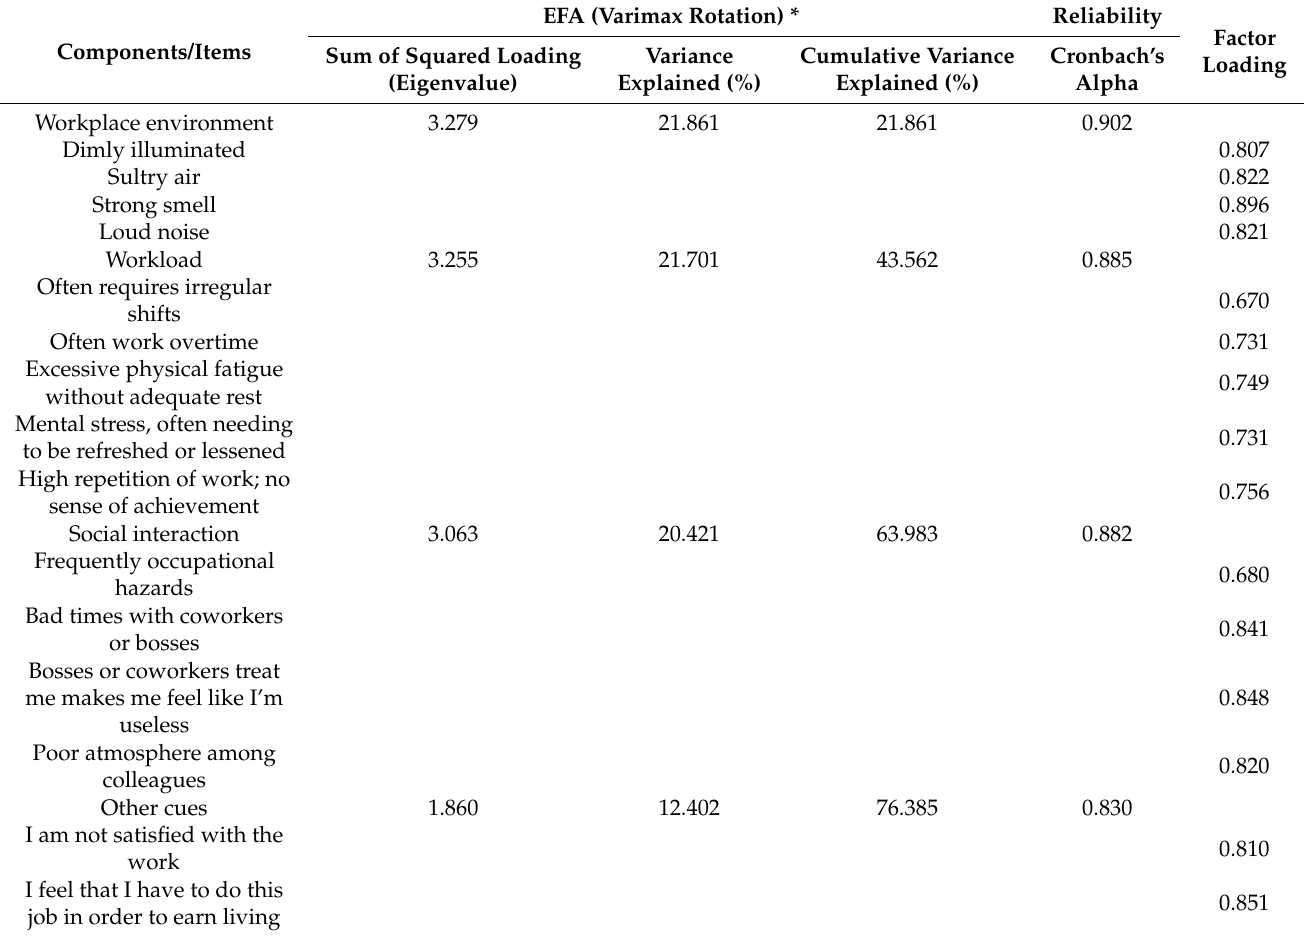
Table 2. Exploratory factor analysis for Workplace Substance Reuse Questionnaire